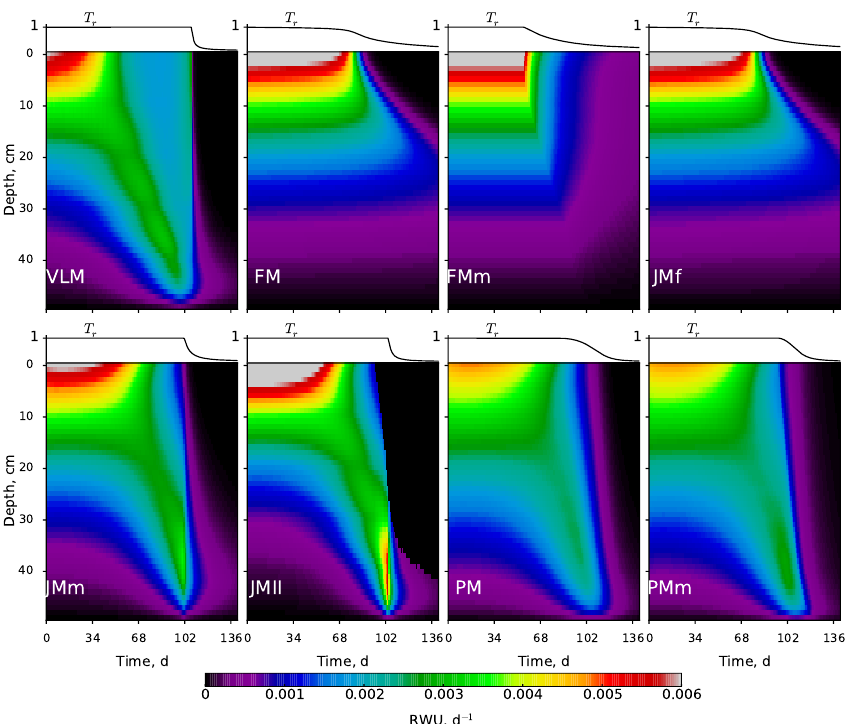
Figure 6. Time–depth root water uptake (RWU) pattern and relative transpiration ( T r ) simulated by the SWAP model in combination with the De Jong van Lier et al. (2013) reduction function and the empirical models, for the sand soil at high root length density and T p = 1mmd − 1 .